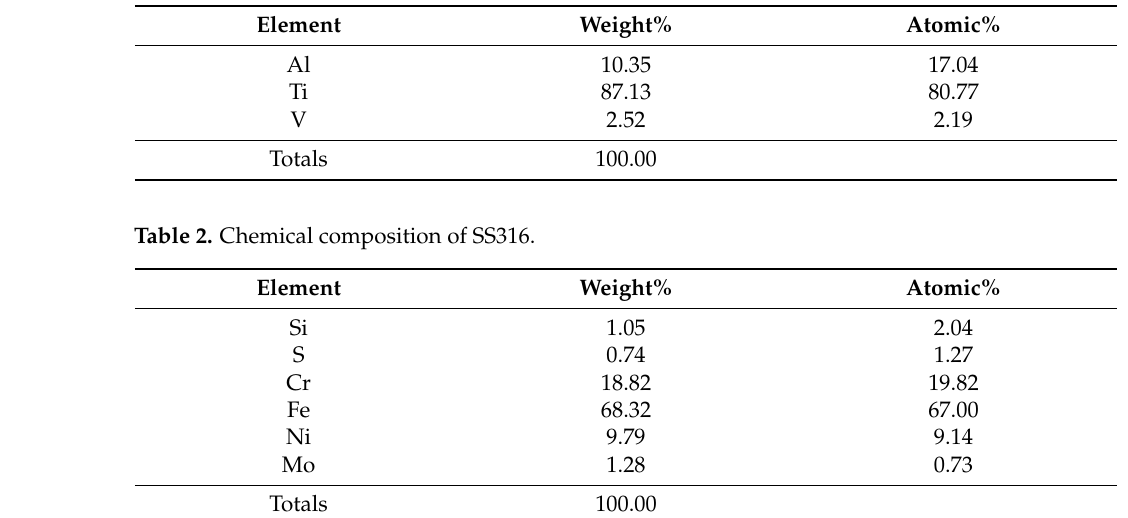
Table 1. Chemical composition of Ti-6Al-4V.